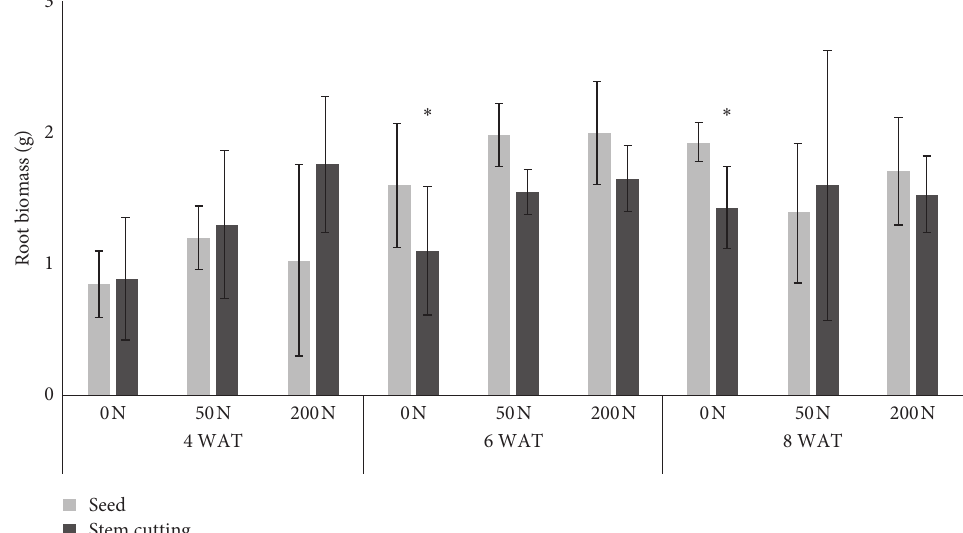
Figure 5: Root biomass (g) of E. pellita seedlings from seeds and stem cutting plant materials at different nitrogen concentrations (0, 50, and 200kg N ha − 1 ) at three selected dates of root measurement: 4 weeks after transplanting, WAT, 6 WAT, and 8 WAT. The mean values were tested using independent samples t -test between seed and stem cutting propagation for each fertilizer treatment and date. All mean values were significantly different ∗ ( P < 0 . 05). Error bars denote standard deviations of the mean ( n � 4).